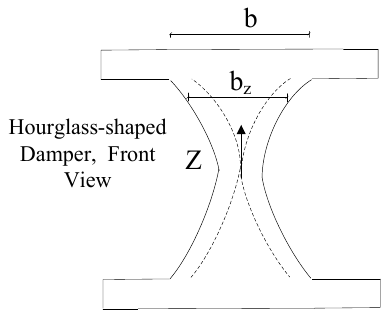
Figure 6. The constant curvature concept.